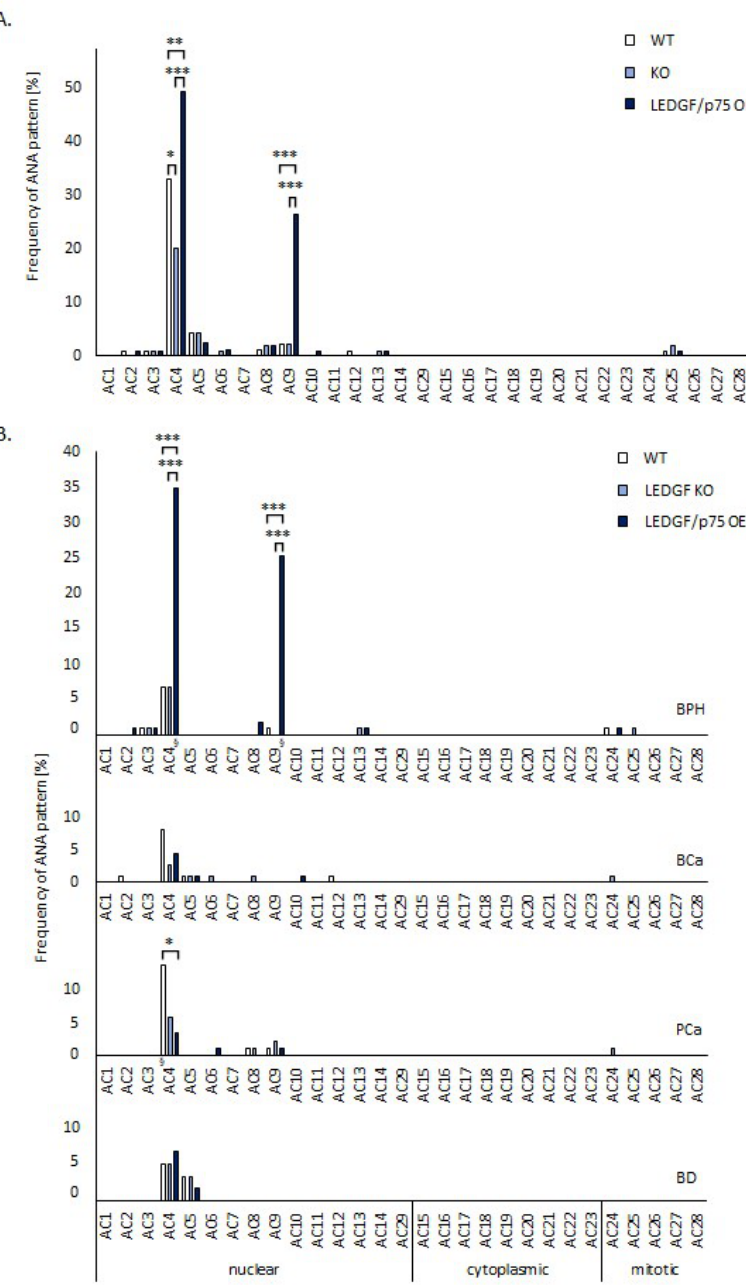
Figure 2. Fluorescence patterns on HEp-2 wild-type (WT), LEDGF/p75 knock-out (KO), and LEDGF/p75 over-expressing (OE) cells. Sera of 60 blood donors (BD), patients with prostate cancer (PCa) (n = 89), with bladder cancer (BCa) (n = 116), and with benign prostate hyperplasia (BPH) (n = 103) were run on wild-type (WT) and recombinantly modified HEp-2 cells. ( A ) Overall frequency in percent (%) of fluorescence ANA--pa(cid:308)ern detected on HEp-2 WT, LEDGF KO, and LEDGF/p75 OE HEp-2 cells after incubation with mentioned serum types according to ICAP criteria. Statistical significance was determined by Fisher’s exact test. ( B ) Frequency in percent (%) of ANA pa(cid:308)erns according to ICAP criteria detected on HEp-2 WT, LEDGF KO, and LEDGF/p75 OE HEp-2 cells detected in patients and BD. * = p < 0.05, ** = p < 0.01, *** = p < 0.001 ; § comparison of BPH patients’ reactivity on LEDGF/p75 OE HEp-2 cells with those of tumor patients and BD, p < 0.001, respec- tively .